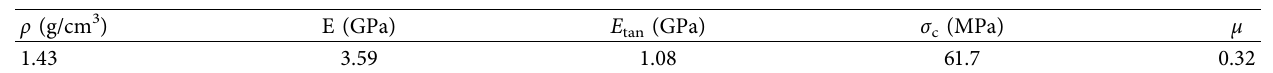
Table 3: Parameters of PVC